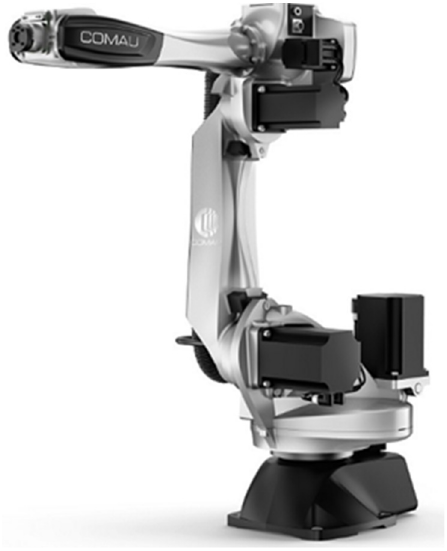
Figure 2. Racer Figure 2. Racer 7-1.4.